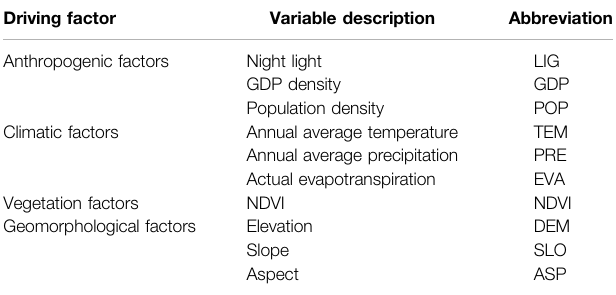
TABLE 2 | Selected potential